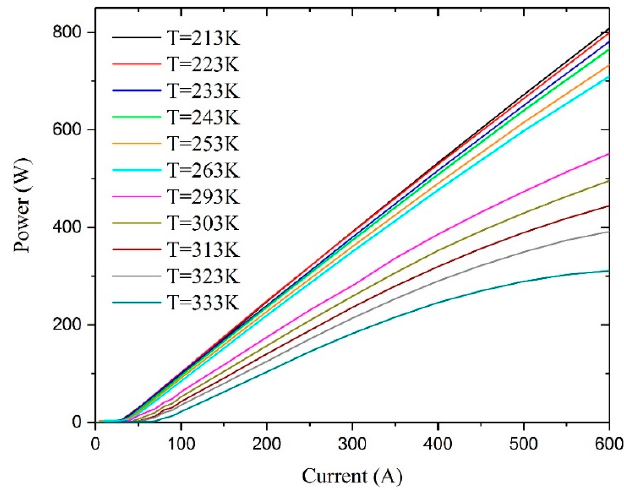
Figure 10. The experimental L-I curves of laser bars from 213 to 333 K.